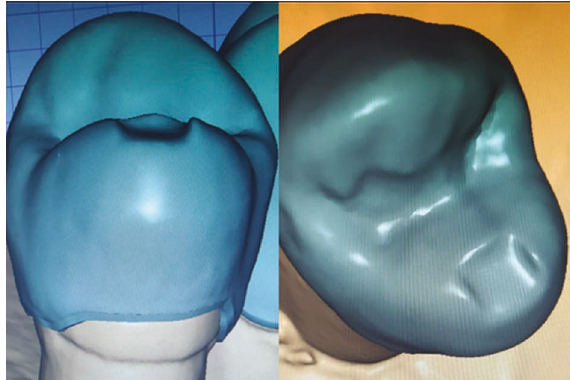
Figure 5: Full contoured maxillary right first premolar design incorporating a half-rounded 2-mm × 0.5-mm indentation on the palatal cusp in ceramill mind CAD software (Amann girrbach, Vorarlberg, Austria).